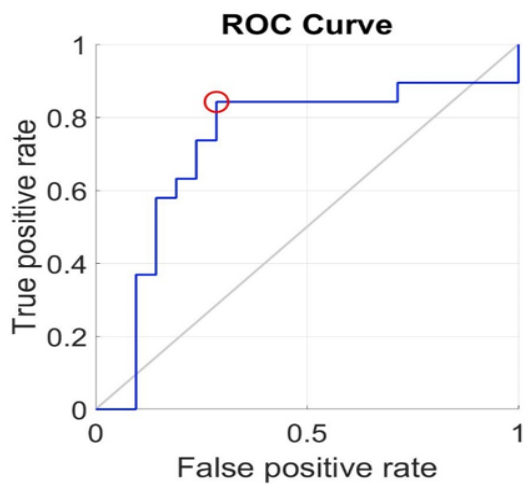
Figure 8. The receiver operating characteristic curve (ROC) for investigation A.